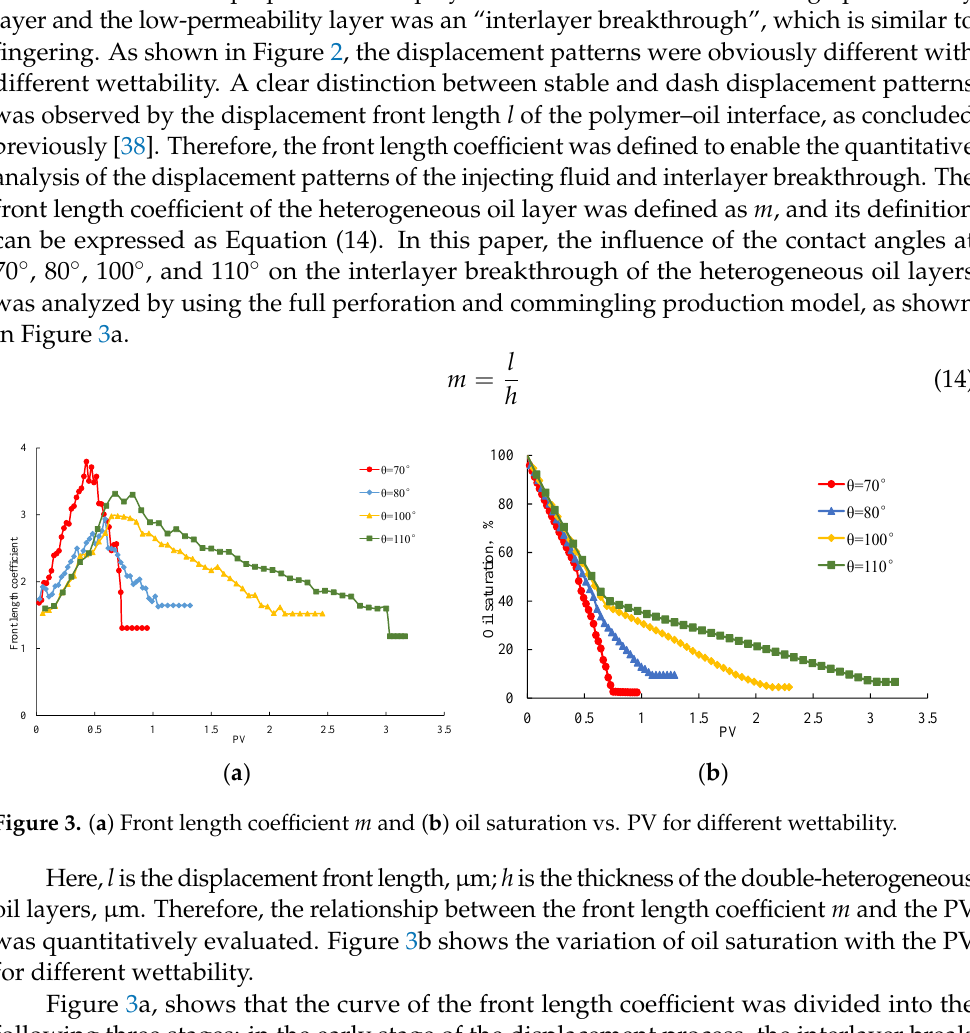
( c ) 0.75 PV Figure 5. Oil saturation distribution of separated layer injection and commingling production. (The polymer solution is represented in blue and the oil in red) By comparing the oil saturation distribution of the three exploitation methods, we ob- served that the full perforation and commingling production models had the highest oil-